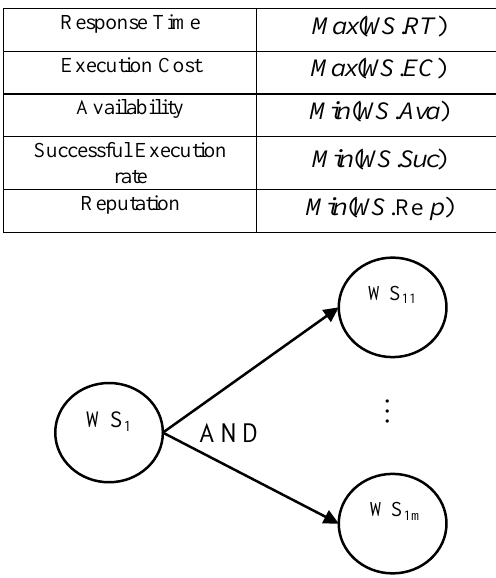
Table 4. Aggregative QoS value for XOR-parallel pattern